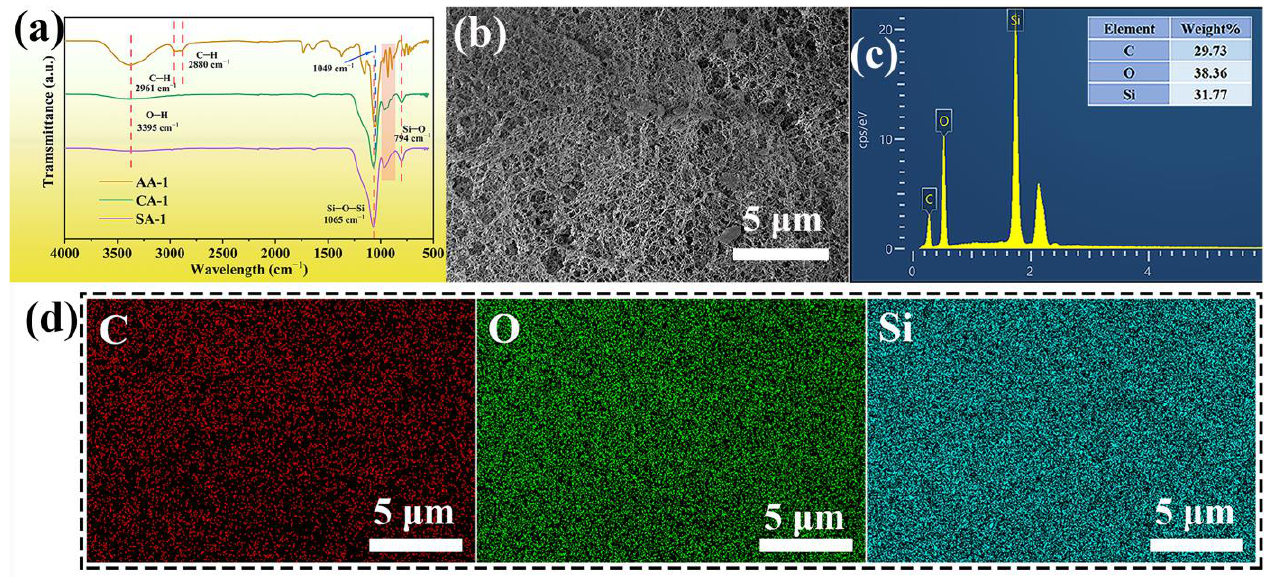
Figure 3. ( a ) ATR-FTIR spectra of AA-1, CA-1, and SA-1. SEM images, ( b ) weight concentration from EDS, ( c ) and EDS elemental mapping images ( d ) for the C, O, and Si elements of CA-2.